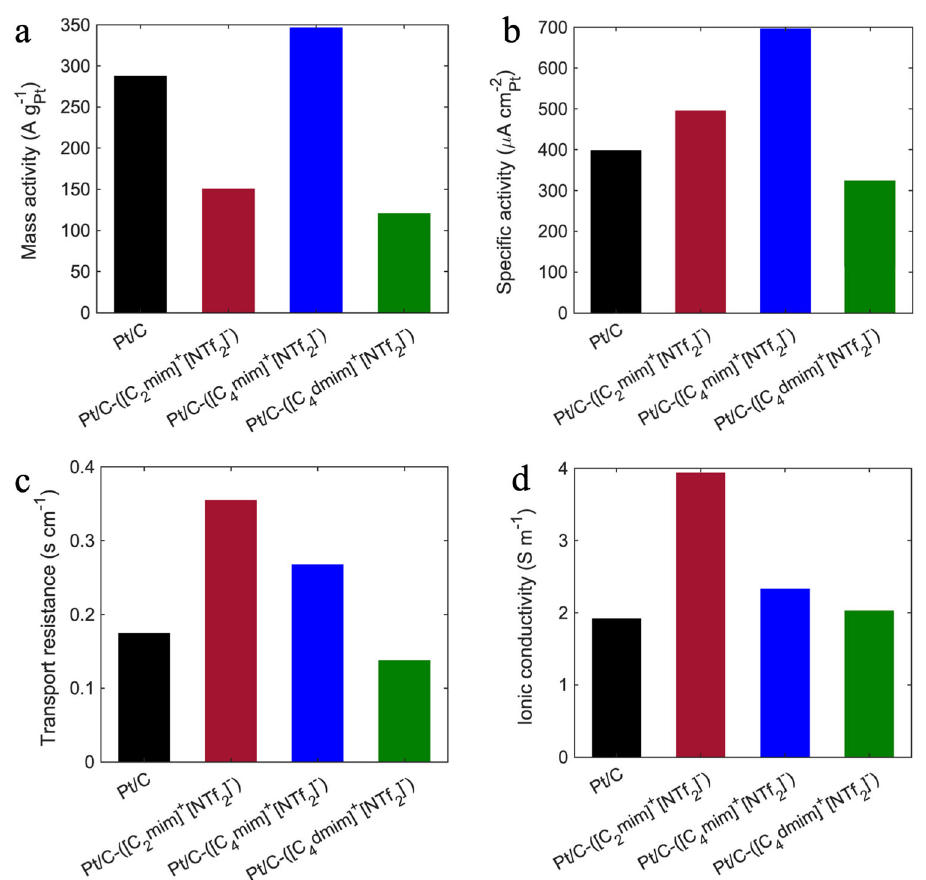
Fig. 5 | Electrochemical characterization of IL-containing MEAs obtained after three voltage recovery cycles vs. baseline Pt/C obtained after two voltage recovery cycles evaluatedat 80°C and 100% RH. a Mass and b speci fi c activities at0.9V,150kPa abs and100%RH,and c localoxygentransportresistancemeasured